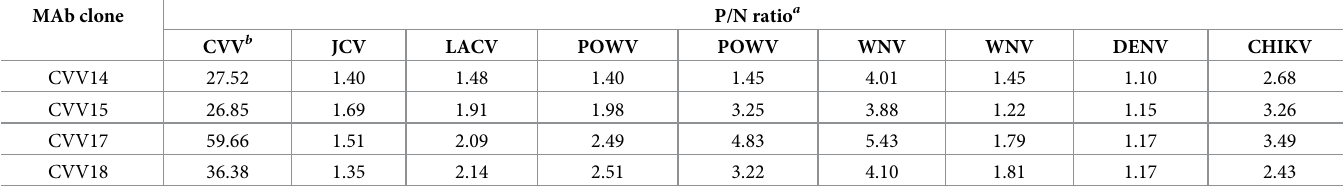
Table 2. Specificity of pilot MAC-ELISA with anti-CVV MAbs as detector Abs.